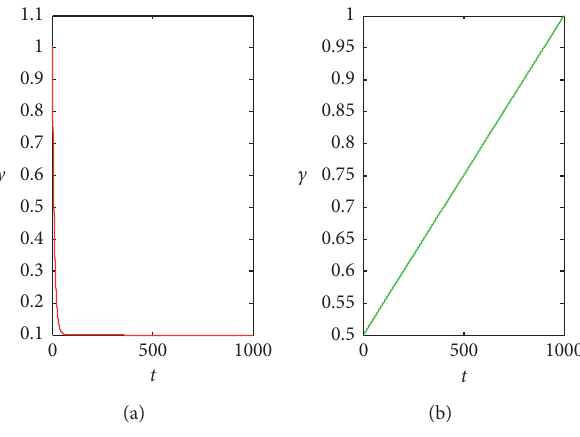
Figure 2: c with the iteration number t